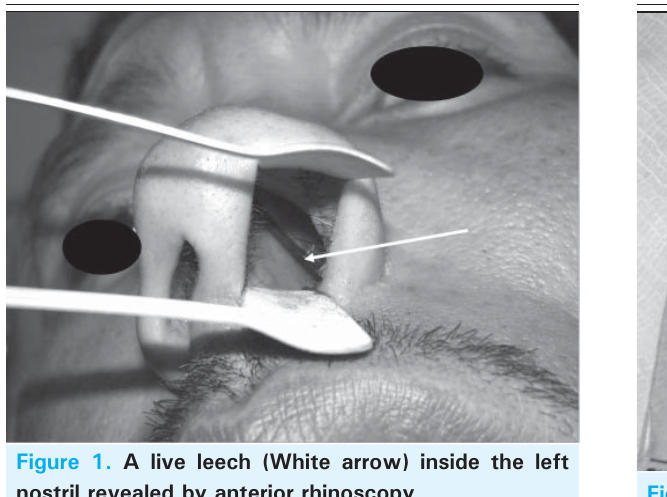
Figure 1. A live leech (White arrow) inside the left nostril revealed by anterior rhinoscopy. Figure 2. The leech recovered from the nasal